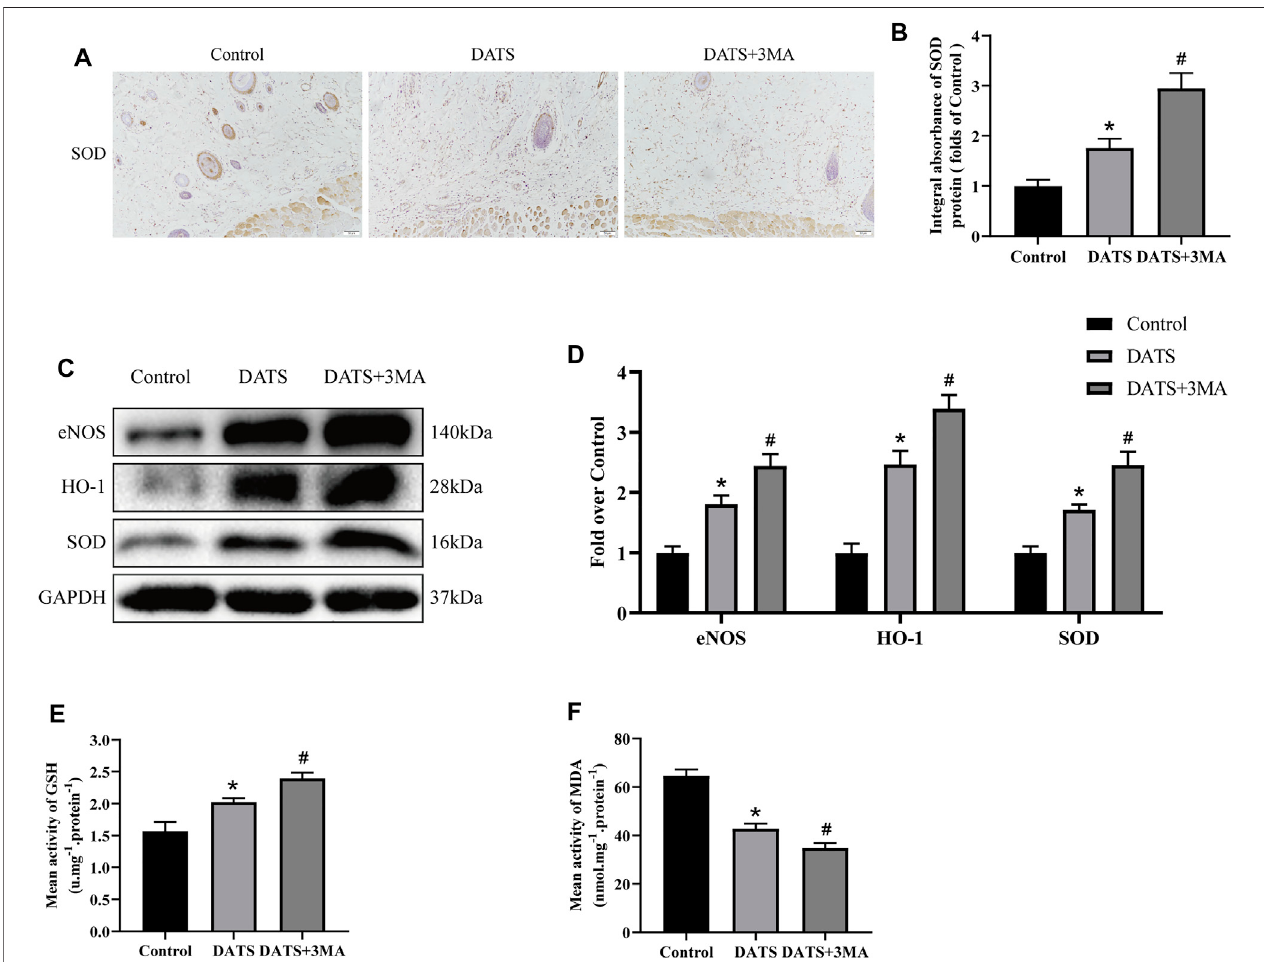
FIGURE5| DATS-induced autophagy affectsoxidativestressinthemultiterritory perforator fl ap. (A) IHCforSOD1inthemultiterritoryperforator fl apineachgroup (original magni fi cation ×200; scale bar, 50 μ m). (B) Statistical chart of the SOD1 expression level estimated by IHC. (C) Western blotting of oxidative stress markers, SOD1,HO-1,andeNOSinthecontrol,DATS,andDATS+3MAgroups.Allthegelelectrophoresisexperimentswerecarriedoutunderthesameexperimentalconditions. (D) Statistical chart of the quanti fi cation of SOD1, HO-1, and eNOS expressions in the perforator fl aps. (E) Statistical chart of the quanti fi cation of GSH. (F) Statisticalchartofthequanti fi cationofMDA.* p < 0.05,vs.controlgroup;# p < 0.05,vs.DATSgroup.Theobtaineddatawereexpressedasmeans±SEM, n =6forevery group. DATS, diallyl trisul fi de; IHC, immunohistochemistry; GSH, glutathione; MDA, malondialdehyde.